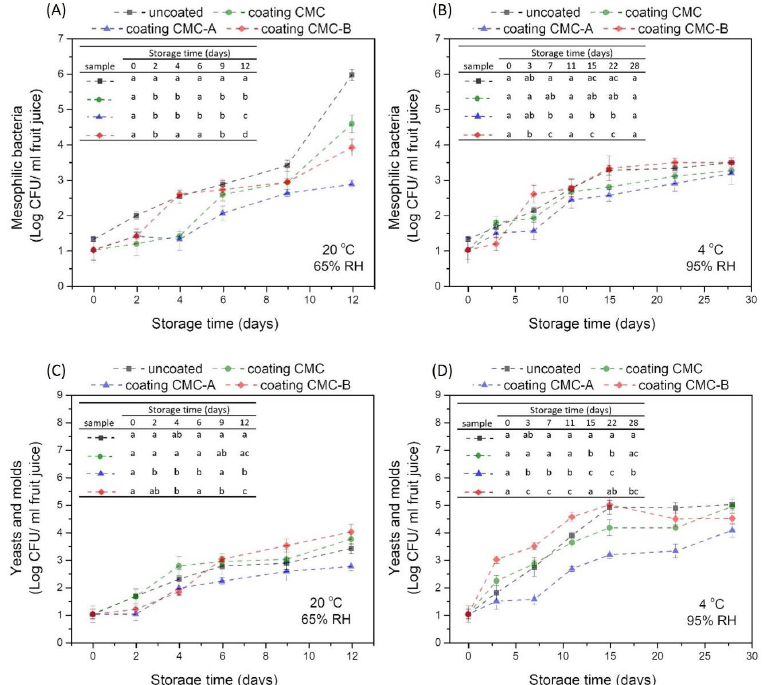
Figure 7. Mesophilic bacteria count ( A ) and ( B ); and yeasts and molds growth ( C ), and ( D ) in the uncoated and coated fresh goldenberries when stored at 20 °C and 65% RH and 4 °C and 95% RH. Results are expressed as mean ± standard deviation ( n = 4). In the inserted table, different letters on the same analysis day correspond to statistically different values for a 95% confidence level. In the same way, the lower values of yeasts and mold growth at 20 °C and 65% RH were achieved for goldenberries coated with the coating CMC-A, being significantly dif- ferent than the other samples only at the end of storage (day 12) as shown in Figure 7C. However, at 4°C and 95% RH (Figure 7D), the fruits coated with the coating CMC-A